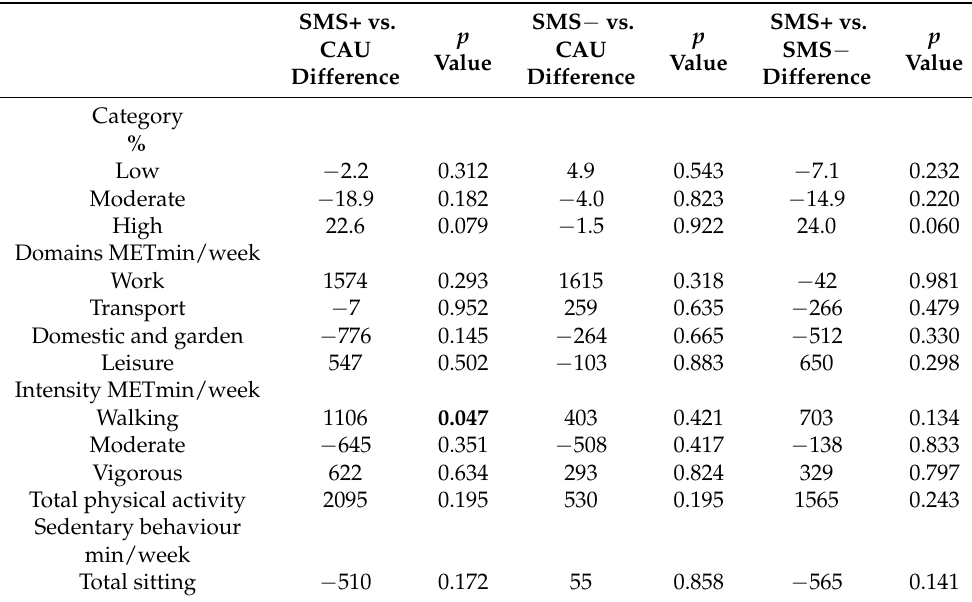
Figure 2. Changes in physical activity category estimates over time. Note: differences were tested with multilevel logistic regression analyses. * indicates significant within-group differences compared with baseline ( p < 0.05). SMS+, lifestyle intervention with SMS support; SMS − , lifestyle intervention without SMS support; CAU, care as usual. Table 3. Differences in physical activity categories and METmin/week between study groups at 12 months.